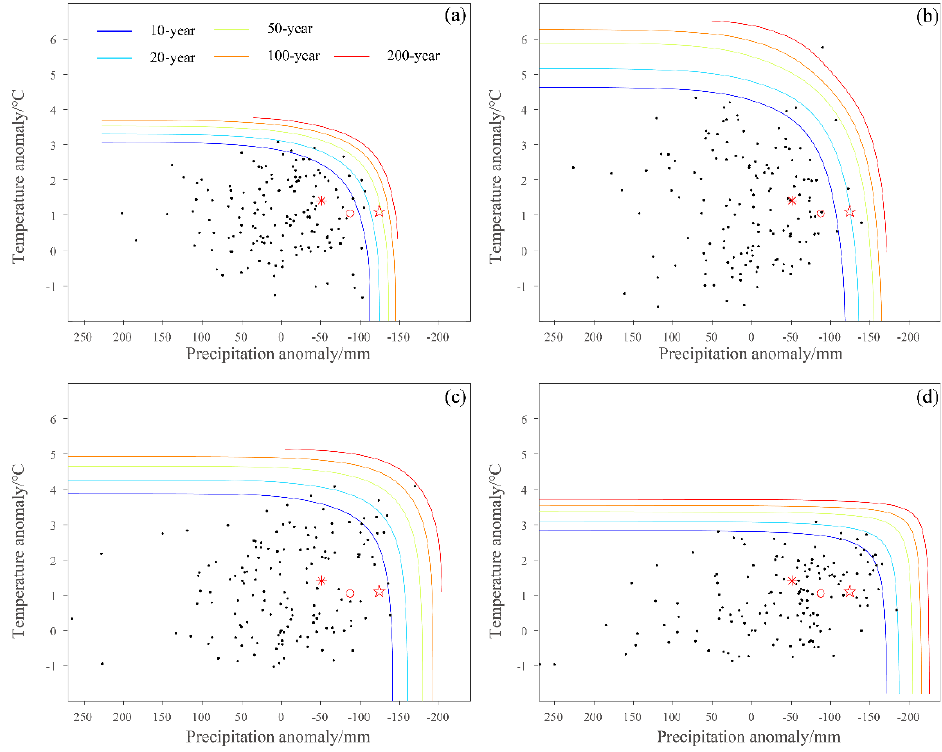
Figure 8. Return period of concurrent events under RCP4.5 scenario for October-March of 1950– 2099 in the study region (( a ) GFDL-ESM2M; ( b ) HadGEM2-ES; ( c ) IPSL-CM5A-LR; ( d ) NorESM1-M; asterisk indicates TEPN; pentagram indicates PETN; circle indicates TNPN; the same below). Under RCP8.5 scenario, compared with the average for the period 1971–2000, the maximum precipitation deficit simulated by GFDL-ESM2M and HADGEM2-ES would be about 150 mm; the difference lies in that the temperature increase simulated by GFDL- ESM2M would be about 5 °C, while the temperature increase simulated by HADGEM2- ES would be over 7 °C. In both cases, TEPN and PETN events would become normal events; the return period for PETN events would be reduced to 20 years (Figure 9a) and